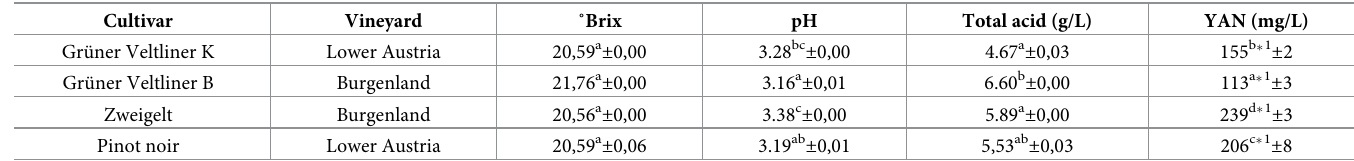
Table 1. Standard wine chemical parameters of the grape juices: Different letters in the same column mean significant differences between the variants.